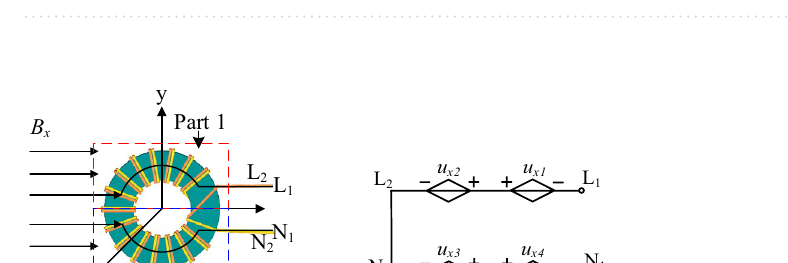
Figure 2. Propagation path of DM noise coupled to the CM choke.